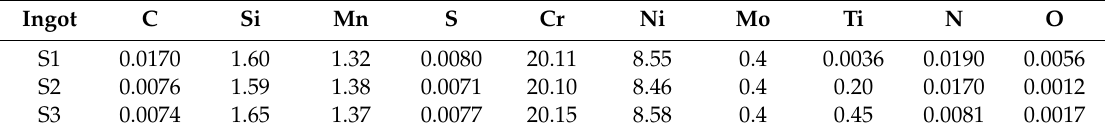
Figure 1. ( a ) The size of cast iron mold and the sampling method; ( b ) tensile specimen from ingot; ( c ) sample from tensile specimen after testing. Table 1. Composition of ingots, mass%.